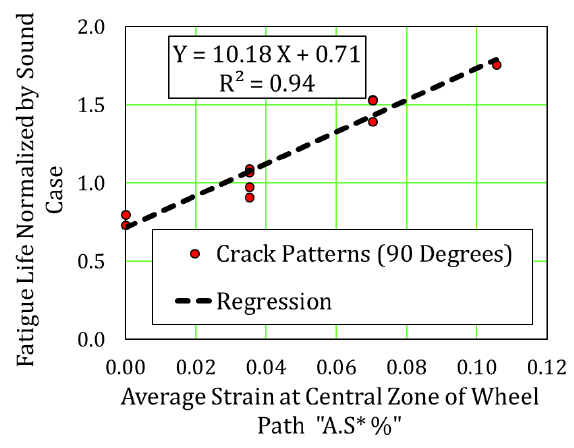
Figure 19. Relation of the average strain of the central zone of the loading path and the remaining fatigue life.